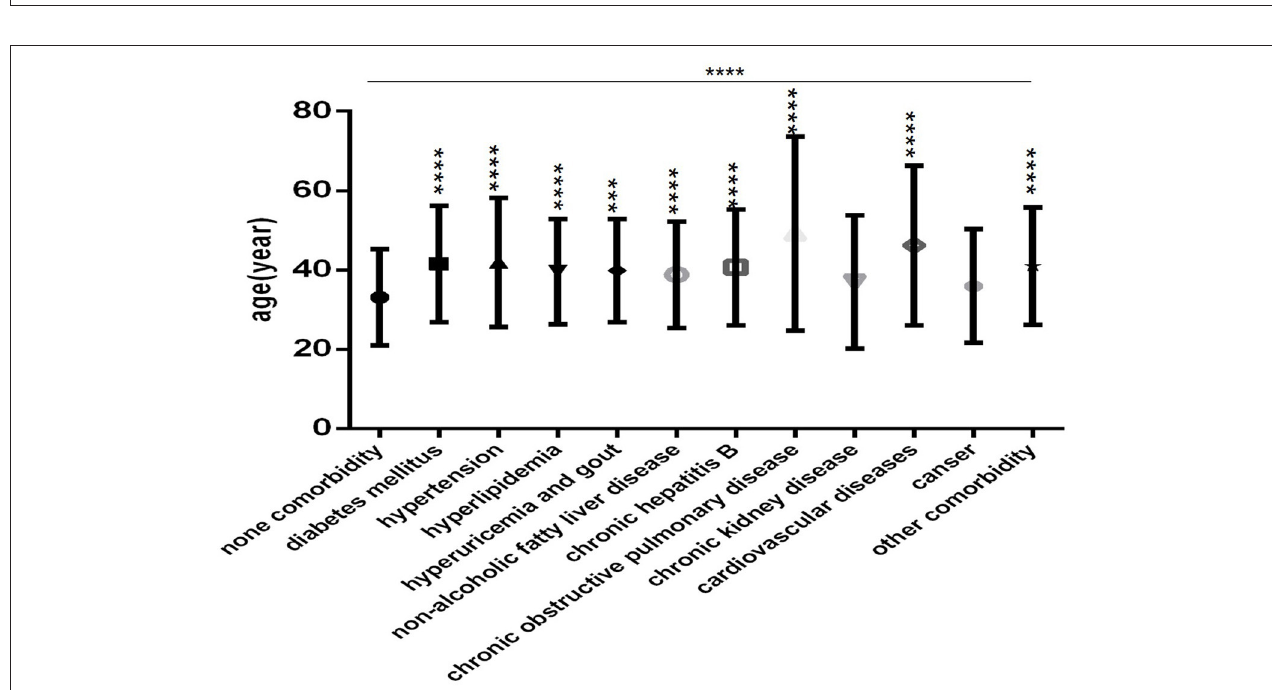
FIGURE 2 | The distribution characteristics of age and comorbidities in COVID-19 patients ( n = 718). COVID-19, coronavirus disease 2019. (A) age. (B) comorbidity.